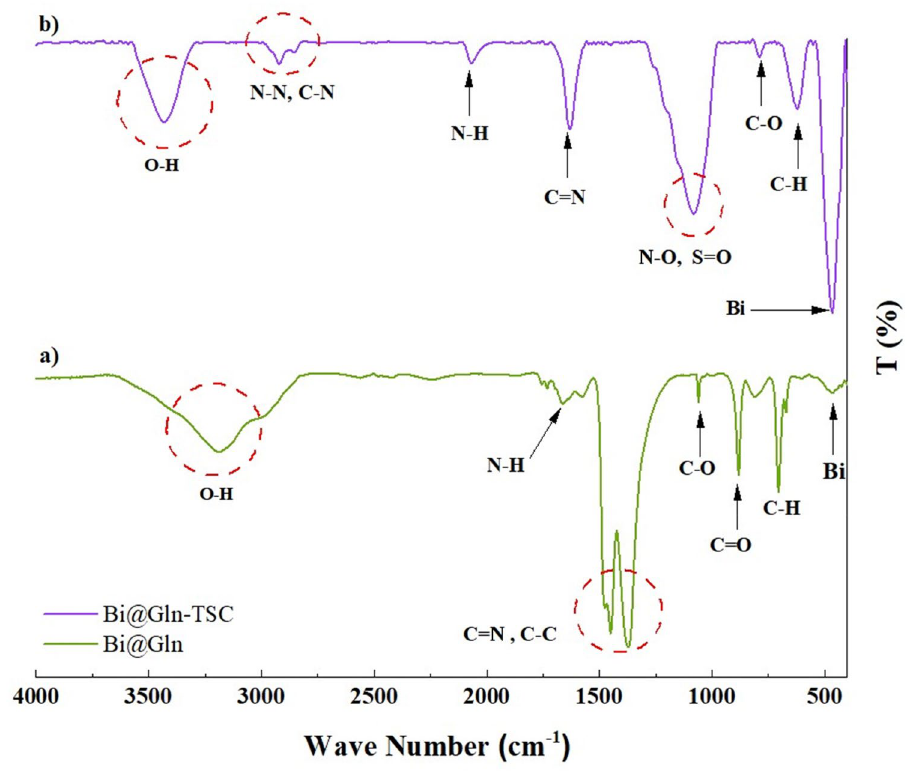
Figure 1. FT-IR analysis of ( a ) Bi 2 O 3 /Gln and ( b ) Bi 2 O 3 /Gln-TSC